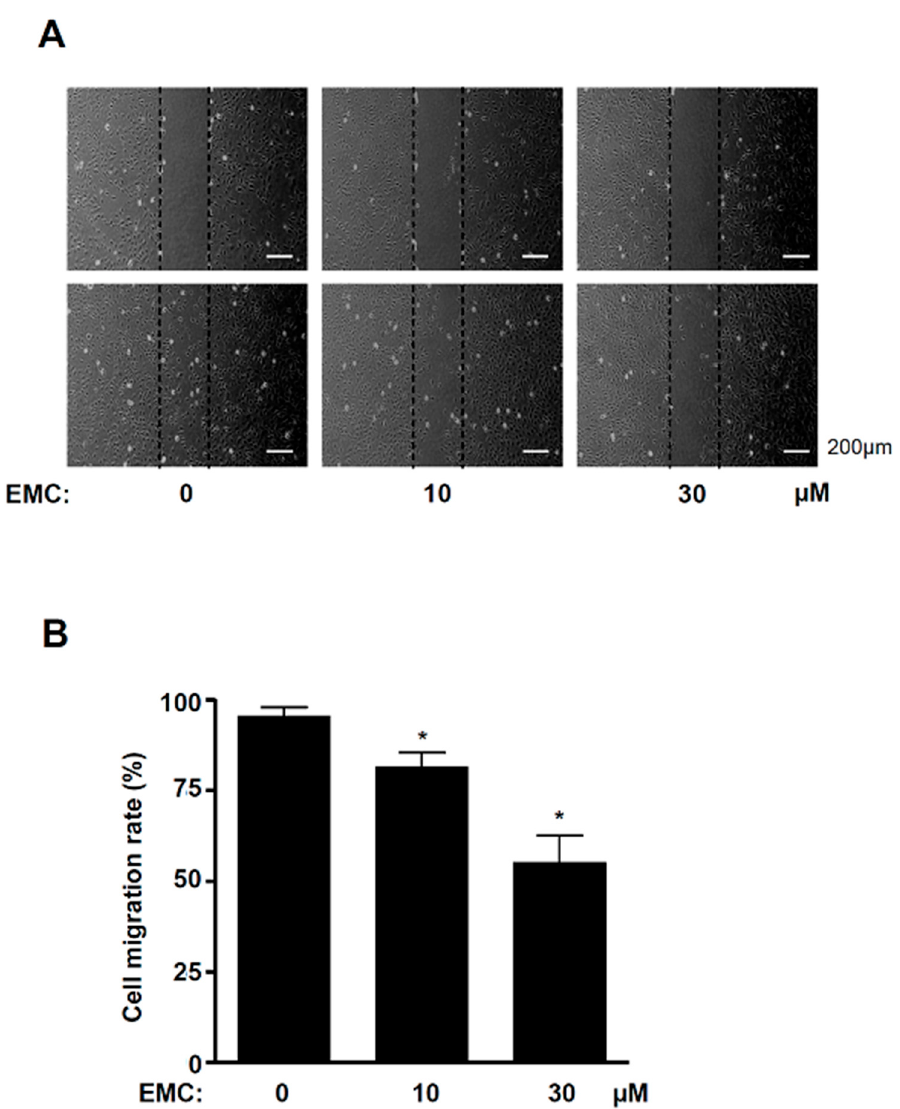
Figure 6. EMC reduces cell migration rate in pre-osteoblasts. ( A , B ) Pre-osteoblasts were treated with EMC for 24 h. Then, cell migration was observed under the phase contrast microscopy ( A ), and cell migration rate (%) was measured by tracing the area enclosing the spreading cell population. It was expressed as a bar graph normalized to the control. Scale bar: 200 µ m. The results are representative of three independent experiments. The data are expressed as the mean ± S.E.M. of the experiments. * ( p < 0.05) indicates statistically significant differences compared to the control.